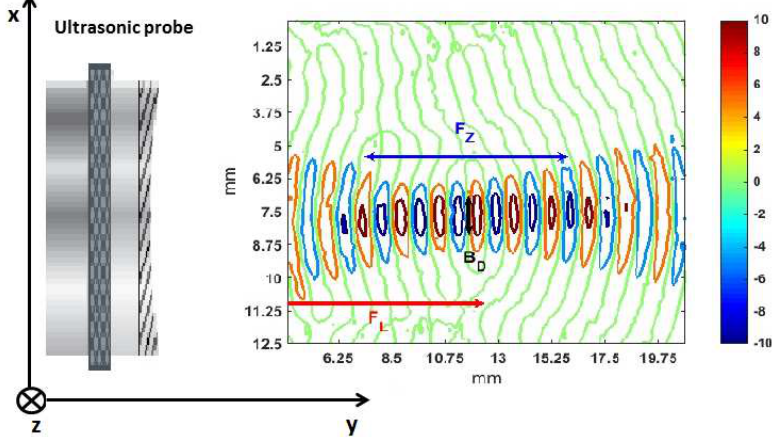
Figure 5. Topographical view of the wave propagation shown in Figure 4. The arrows indicate the focal length F